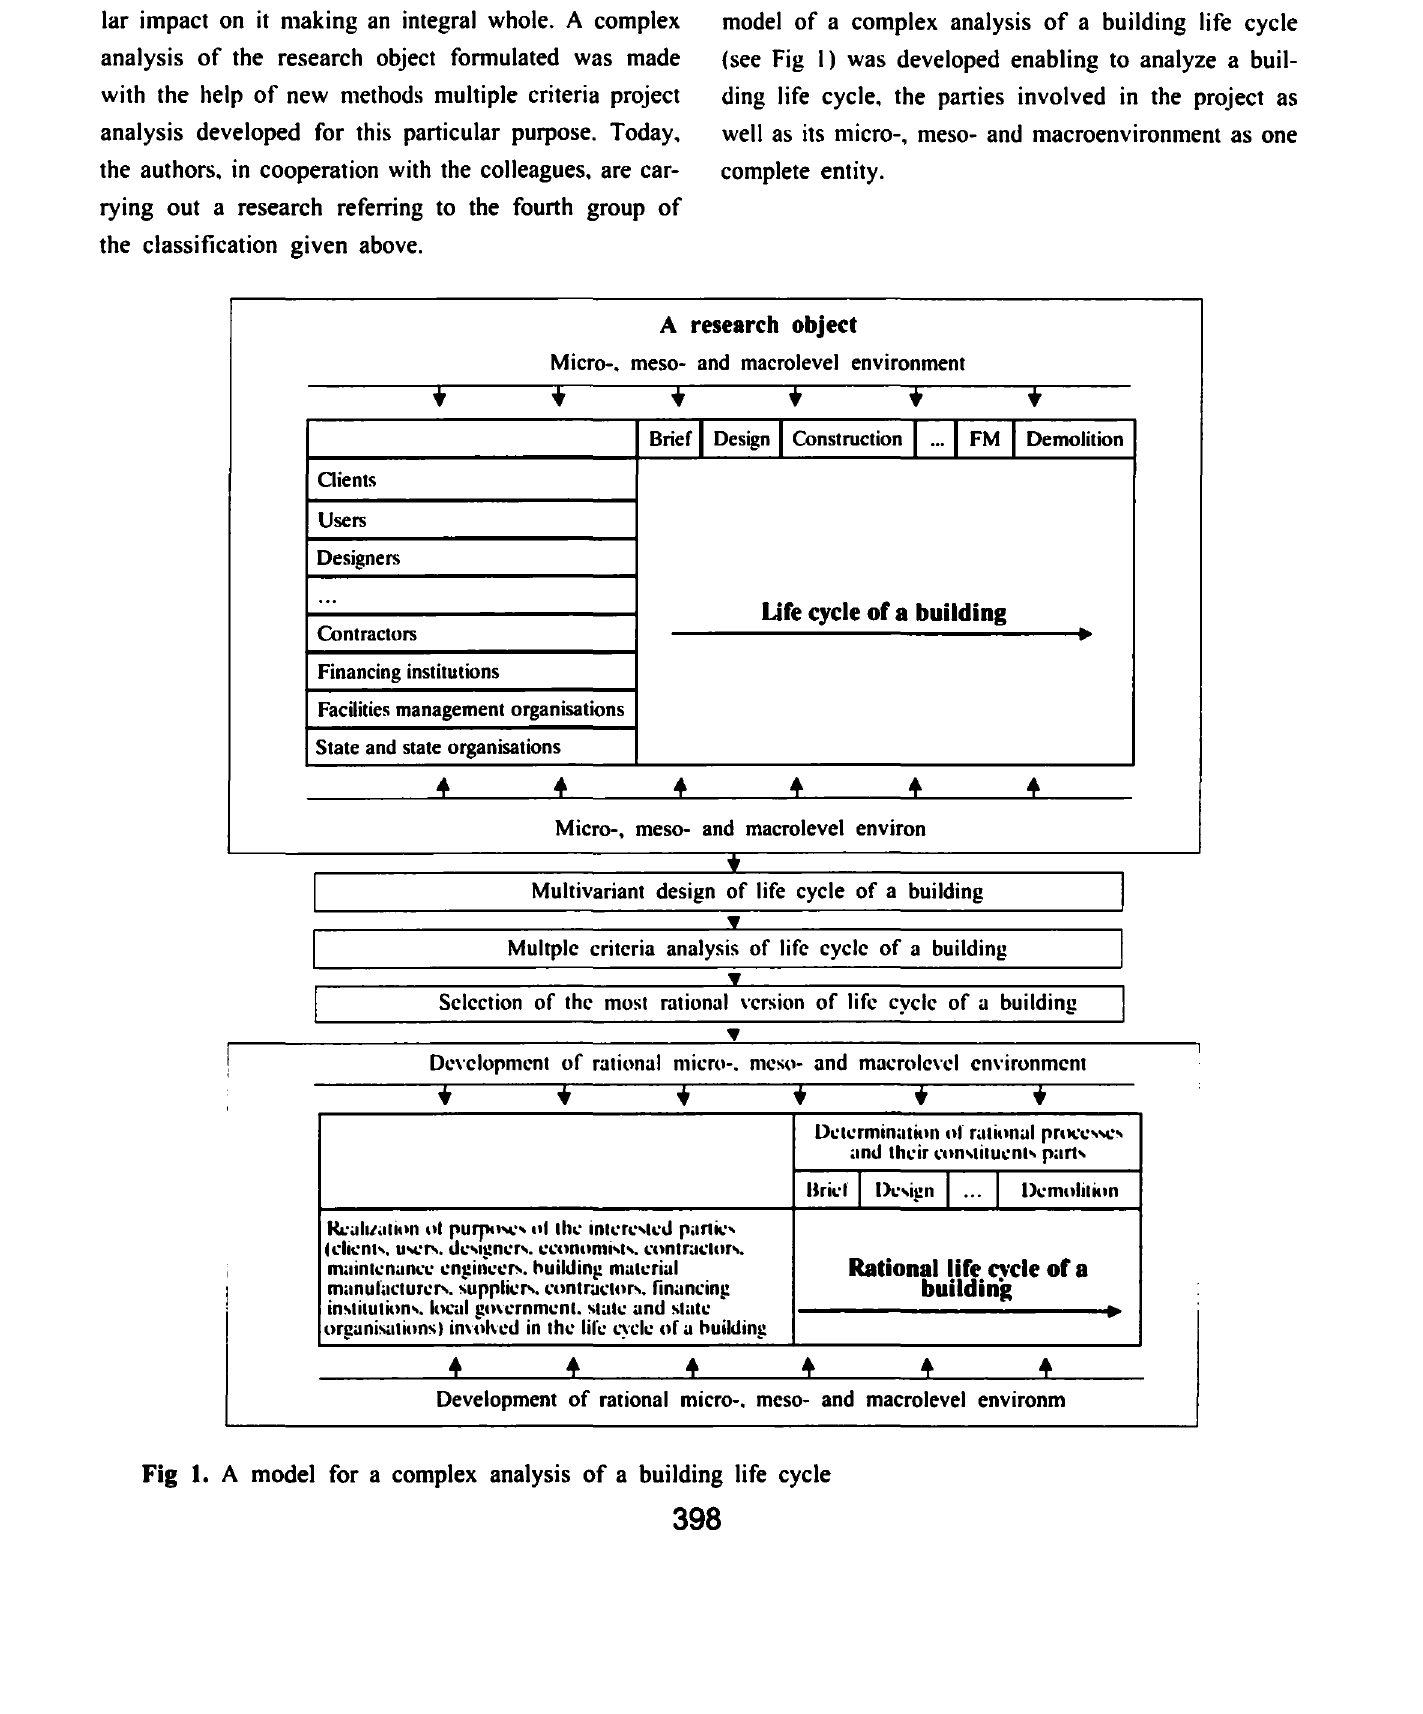
Fig 1. A model for a complex analysis of a building life